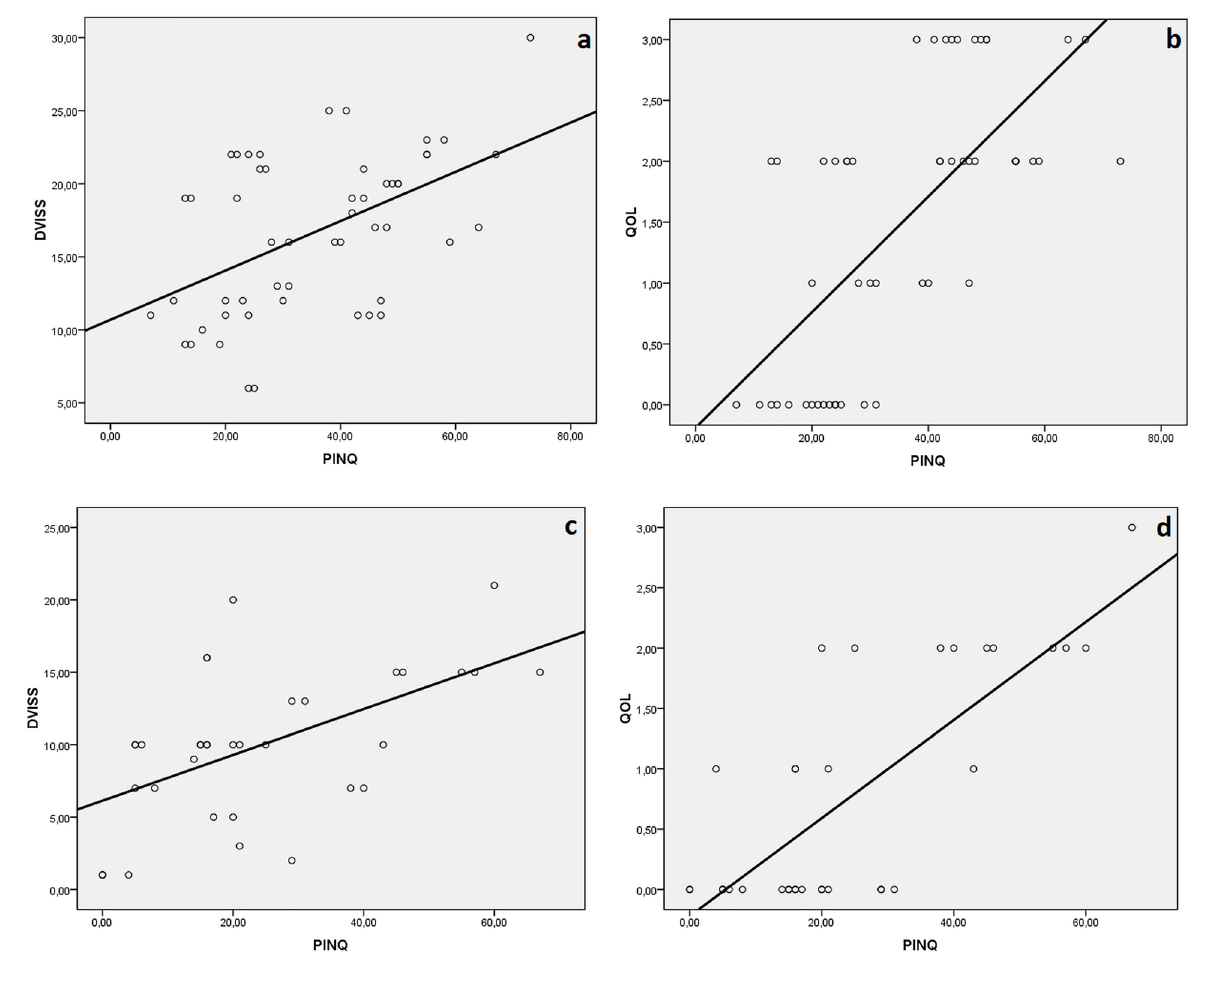
Figure 3 - Scatter plot with trend line of patients with overactive bladder-related urinary incontinence before and after vitamin D